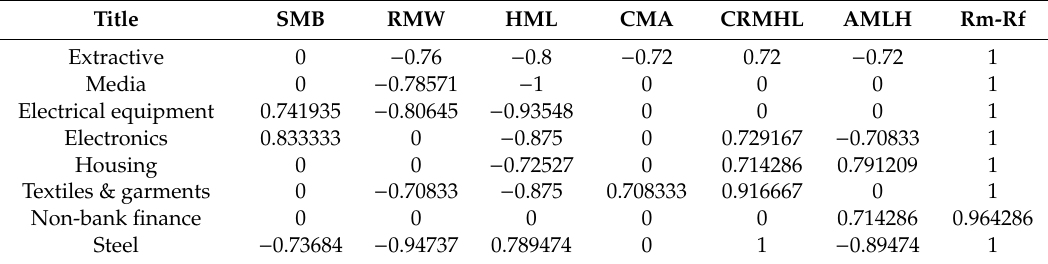
Table A2. Significance level of factors in di ff erent